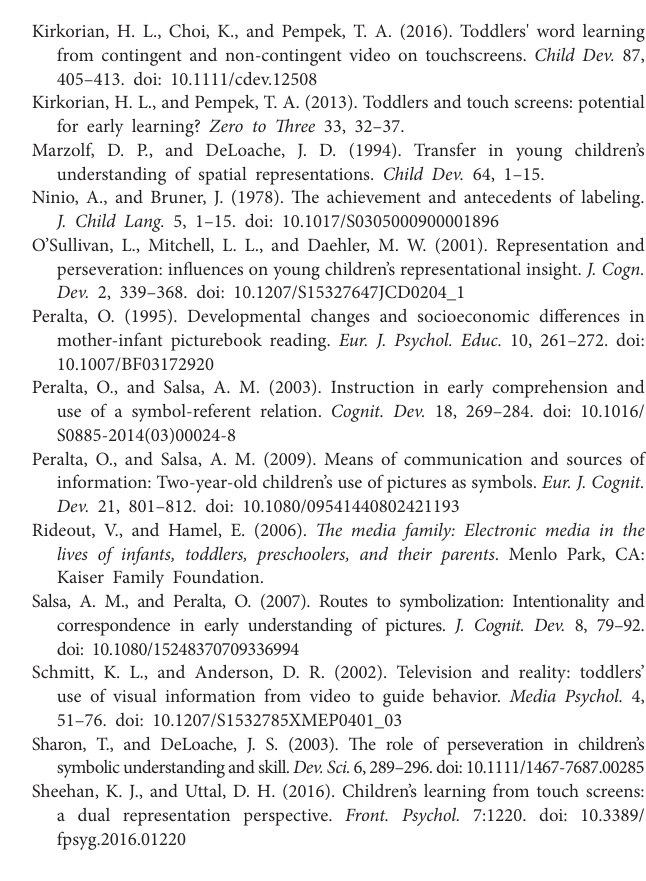
SUPPLEMENTARY FIGURE S1 | Photograph of the hiding room and the tablet. SUPPLEMENTARY FIGURE S2 | Children’s correct responses by block and